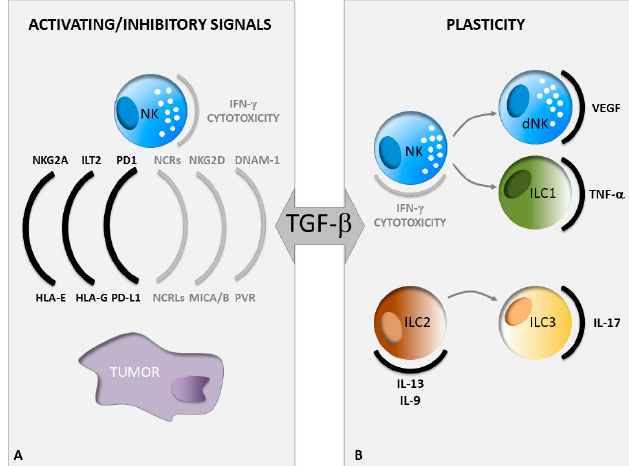
Figure 1. Impact of TGF- β on ILC functions in cancer. ( A ) Phenotypic changes of both NK and tumor cells in a TGF- β rich tumor microenvironment. The grey or black color indicates a decrease or an increase in the expression levels of the depicted molecules, respectively. ( B ) TGF- β -driven conversion of one ILC subset into another, ILC, innate lymphoid cells; NK, natural killer.